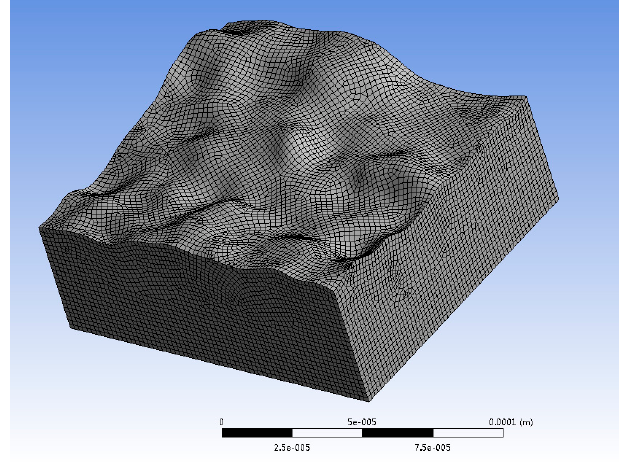
Figure 6. Meshing of the WEDM’ed rough surface for solving the thermal model.